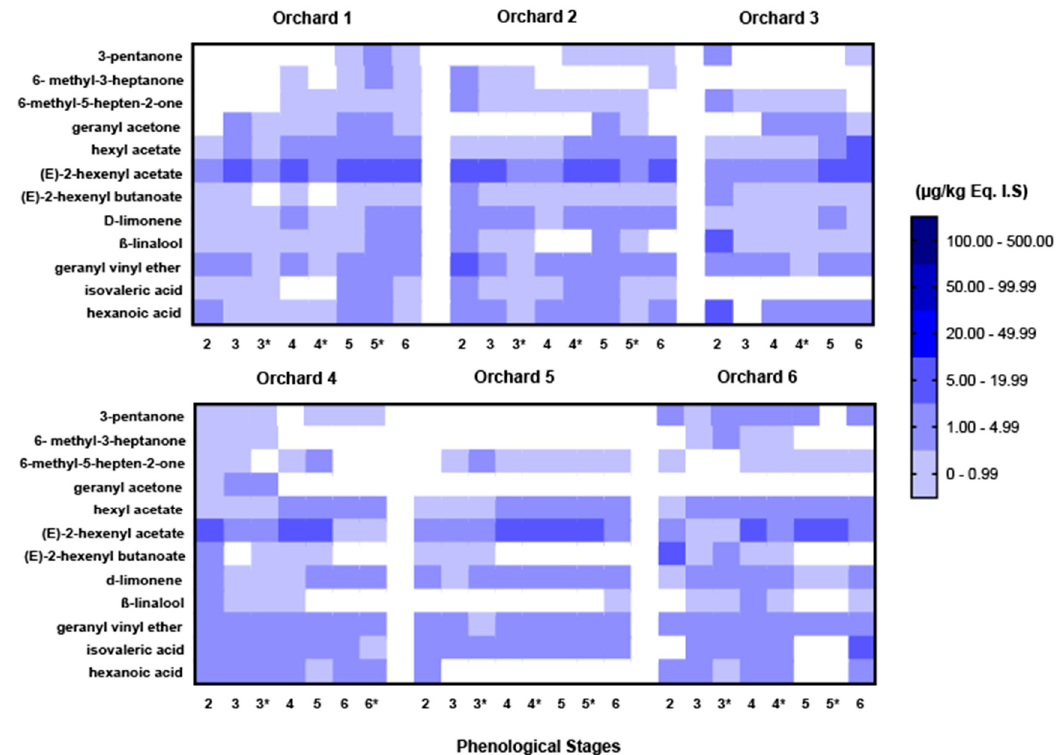
Figure 4. Volatile alcohols concentration in pulped Regina sweet cherries during development in orchards 1 to 6. 3*, 4*, 5* and 6* indicate samples with the herbaceous flavor. White cells mean absent or not detected.